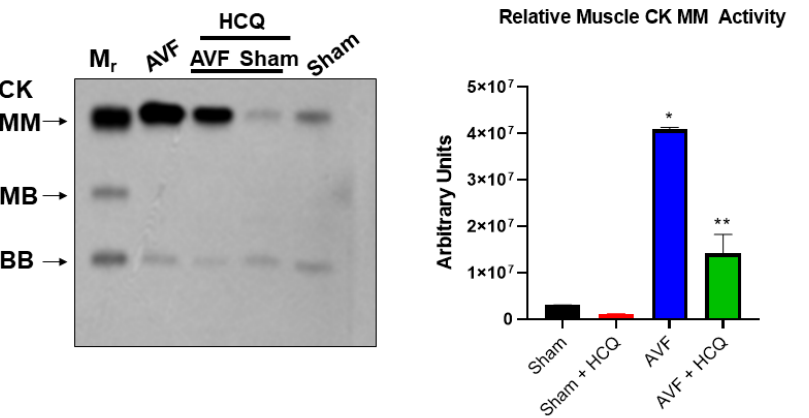
Figure 2. Representative serum in gel-muscle CK activity (left side gel picture); the bar graph represents the average scanned values of AVF and sham mice with and without the HCQ treatment (right side bar graph). *, <0.05 compared with sham, **, <0.05 compared with AVF; n = 5–8 in each group.